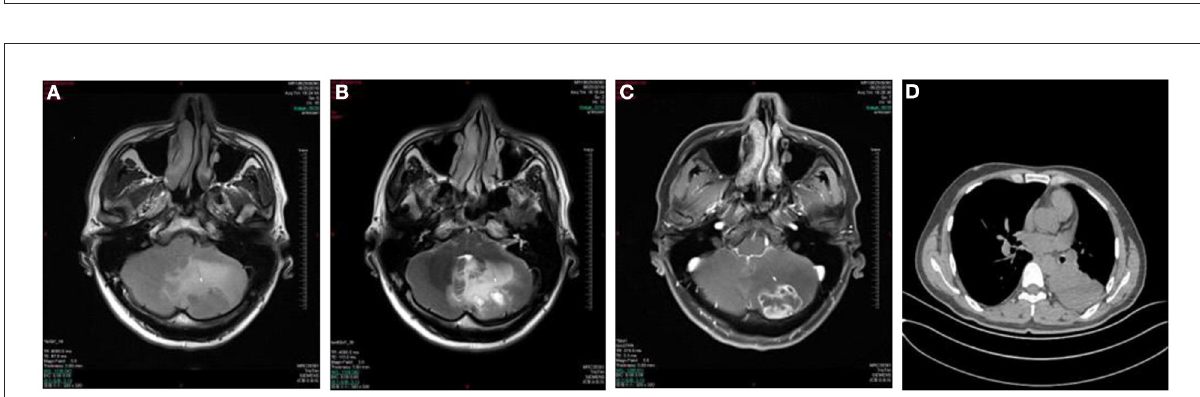
FIGURE3 Case 6: metastasis of the left cerebellar hemisphere. Axial T1WI (A) and Axial T2WI (B) show irregular lesion and surrounding edema in the left cerebellar hemisphere with the heterogeneously hypointense signal on T1WI and marked hyperintense signal on T2WI relative to the normal parenchyma of the cerebellum. The lesion shows ring-enhancement on postcontrast axial T1WI with fat saturation (C) . Chest CT shows a soft tissue attenuation mass in the lower left lung (D) .